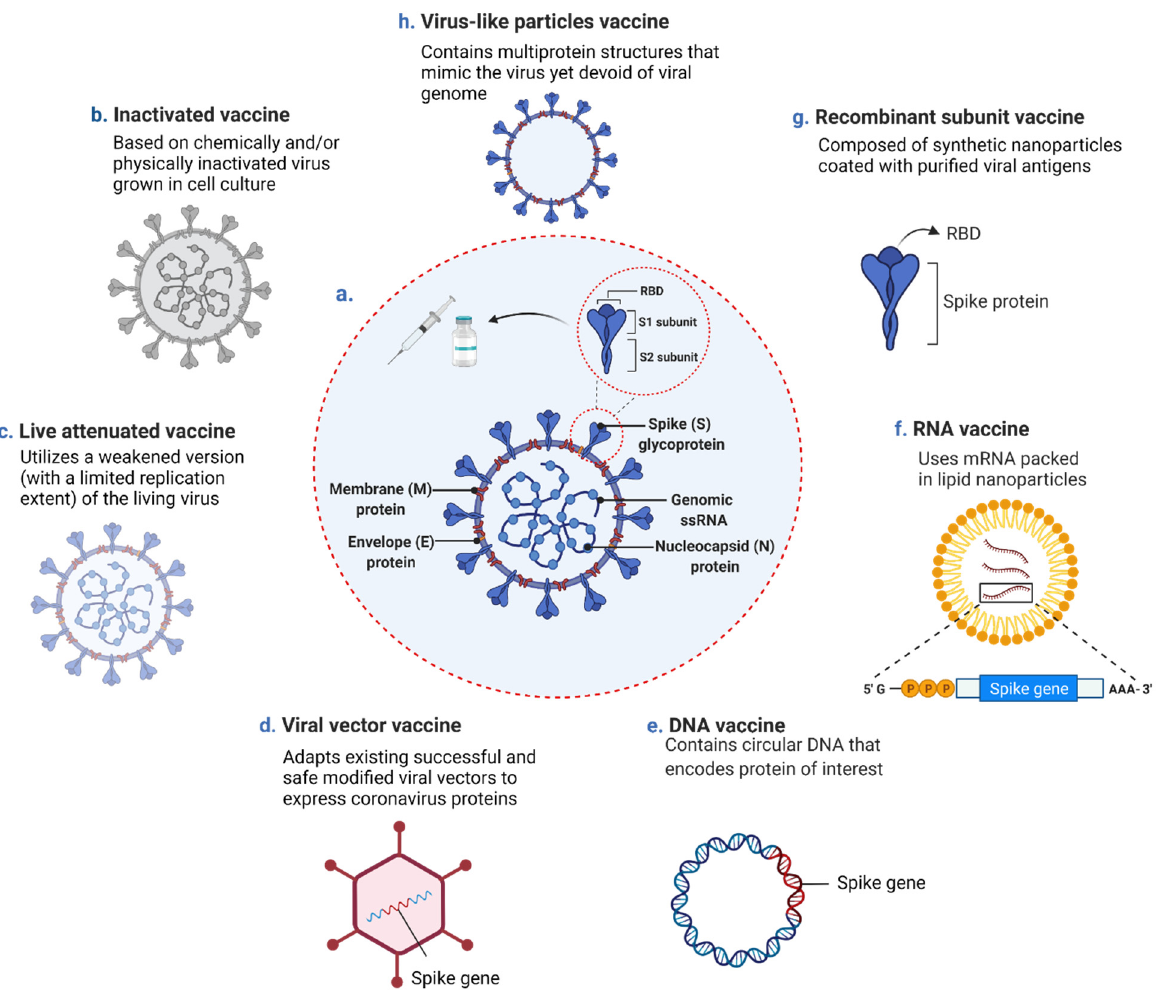
Figure 1. SARS-CoV-2 structure and contemporary COVID-19 vaccine platforms. ( a ) Schematic diagram of SARS-CoV-2 structure including the single-stranded RNA (ssRNA) genome and the four structural proteins: spike protein (S), envelope protein (E), membrane protein (M), and nucleocaspid protein (N). Diverse vaccine platforms including ( b ) inactivated vaccine ( c ) live attenuated vaccine ( d ) viral vector vaccine ( e ) DNA vaccine ( f ) RNA vaccine ( g ) recombinant subunit vaccine ( h ) virus-like particles vaccine. mRNA: messenger RNA, RBD: receptor-binding domain. The diagram was created with BioRender.com.